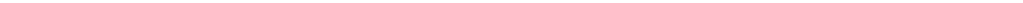
figure on next Fig. 2 Up-regulation of C/EBPβ is involved in TGF-β-induced EMT. a Real-time PCR analysis of C/EBPβ mRNA levels in A549 cells treated with 0 20 − ng/mL TGF-β for 24 h. b C/EBPβ mRNA levels increased in a time-dependent manner of TGF-β (10 ng/mL) treatment (0 48 h) in A549 cells. c TGF-β − increased C/EBPβ protein levels in A549 cells in a concentration- (0, 1, 2.5, 5, 10, and 20 ng/mL) dependent manner. d C/EBPβ expression increased gradually by 7.05 0.81 folds by 24 h when TGF-β treatment was prolonged. e , f Quantification of western blots were calculated according to ± grey analysis. g Luciferase activity assay was performed to assess C/EBPβ promoter activity. Generation of reporter gene constructs controlled by the human α-SMA gene promoter. Reporter constructs were generated by inserting fragments of the α-SMA gene promoter into a luciferase reporter vector pGL4.10. The location of the C/EBPβ-binding motif is as indicated. Relative to the control, the activity of C/EBPβ-luciferase increased with TGF-β concentration and peaked at 10 ng/mL by 2.74 0.42-fold. h TGF-β up-regulated C/EBPβ-luciferase activity. Traces represent three ± experiments with similar results. Means SEM of data are shown. Asterisk (*) denotes significant difference (P < ±